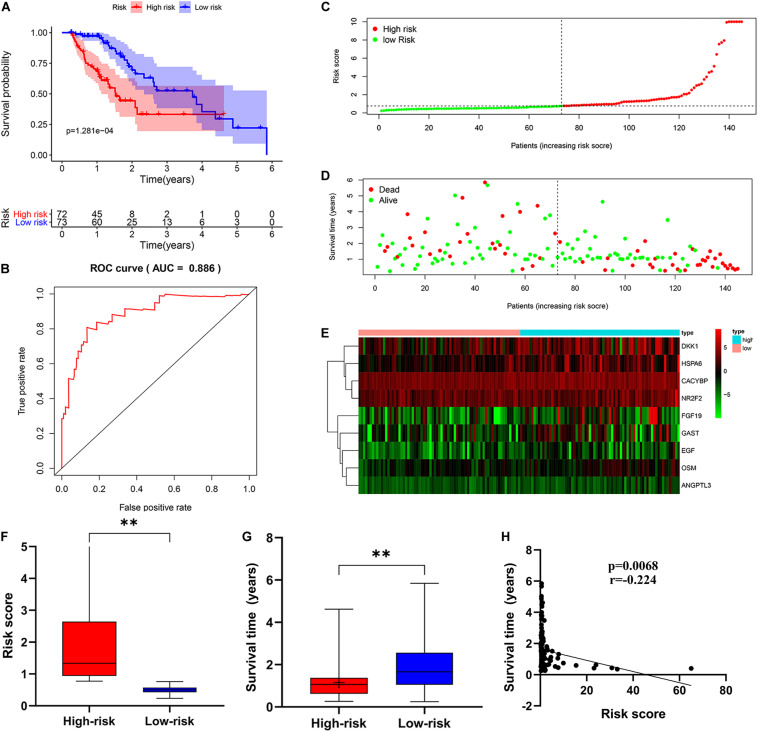
The prognostic value of the immune-related risk score. (A) Patients in high-risk group suffered shorter OS. The blue represents the overall survival of patients in the low-risk group; the red represents the overall survival of patients in the low-risk group. (B) Survival-dependent receiver operating characteristic (ROC) curve validation of prognostic value of the prognostic index. (C) The risk score distribution. Green dots represent risk score for low-risk patients; red dots represent risk score for high-risk patients. (D) The relationship between survival status and risk score. The abscissa represents the number of patients, and the ordinate is the risk score. Red dots represent dead patients, green dots are living patients. (E) Risk gene expression and risk score (abscissa) in EC patients. (F) Risk score in high and low-risk group. (G) Patient survival time in high and low-risk group. (H) The correlation between survival time and risk score. *p < 0.05, **p < 0.001.